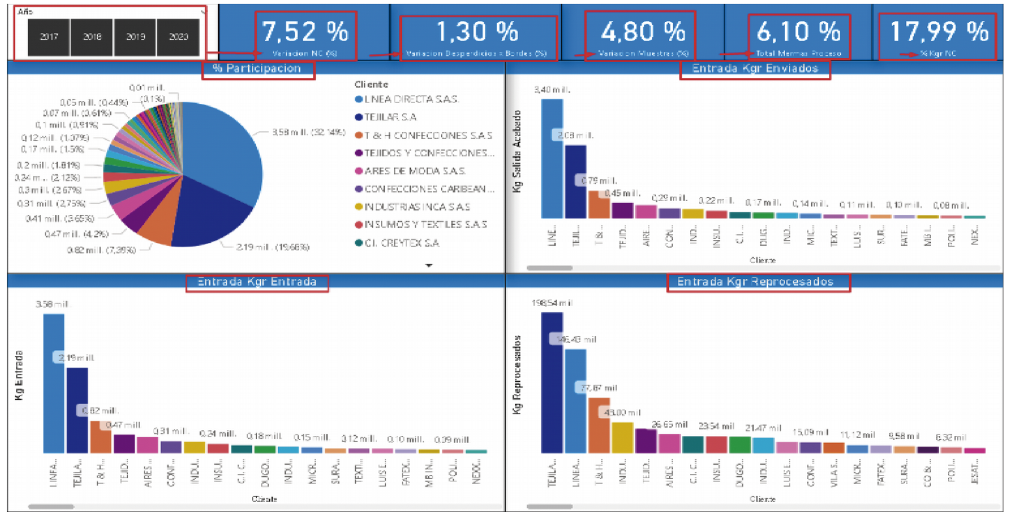
Figure 9. dashboard of kilograms reprocessed in the industrial